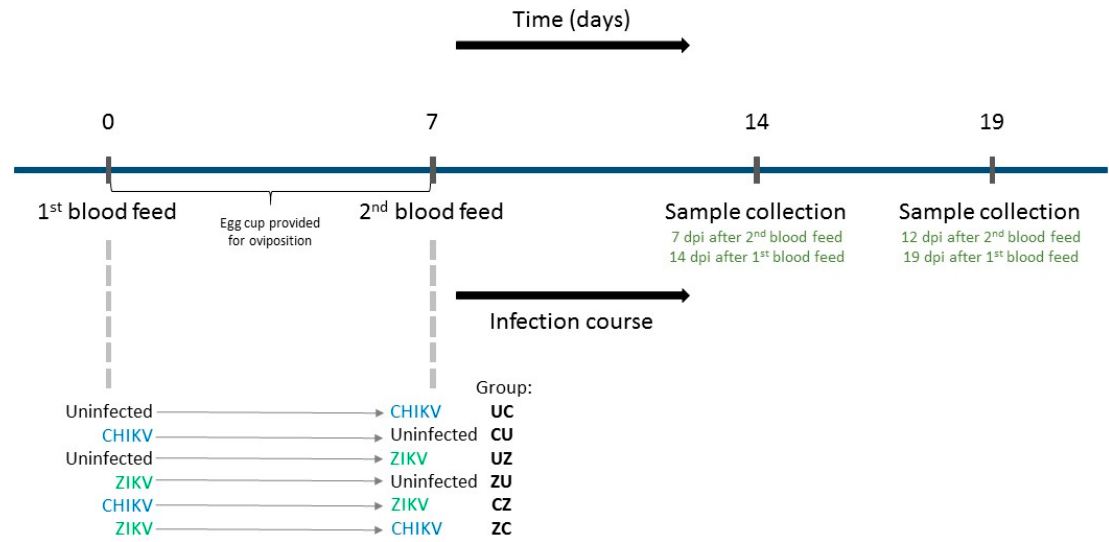
Figure 1. Experimental design of sequential infections of adult Ae. aegypti (Poza Rica). A first blood meal with uninfected blood, CHIKV, or ZIKV was given to the mosquitoes, and 7 days later a second blood meal was offered with uninfected blood, CHIKV, or ZIKV. Sample collection (bodies, legs/wings, and saliva) was performed at 7 and 12 days post infection (dpi) following the second blood meal.